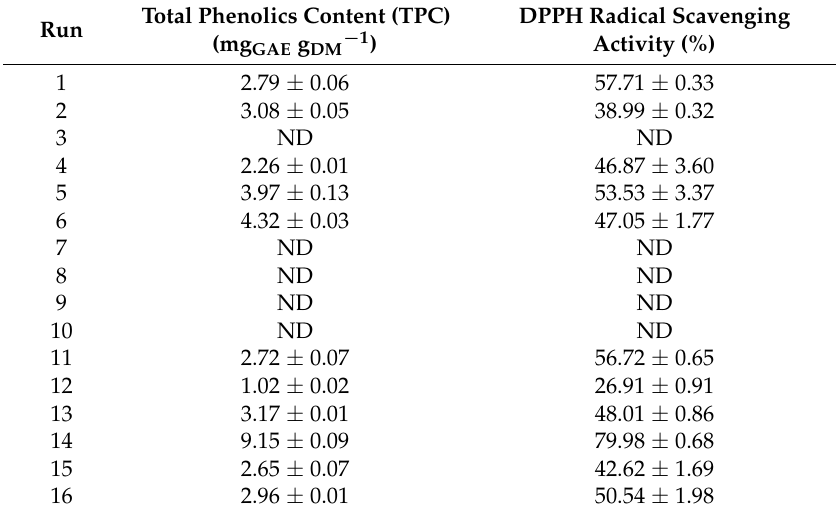
Table 5. Total phenolics content (TPC) in supercritical fluid sage leaf extracts expressed as mg of GAE g − 1 of DM and 2,2-diphenyl-1-picrylhydrazyl (DPPH) radical scavenging activity expressed as % DPPH radical scavenging activity at 25 µ g mL − 1 concentration.